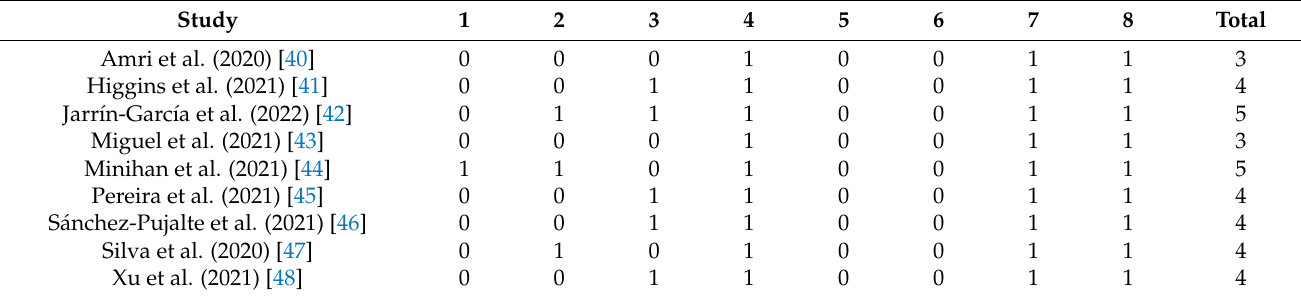
quate response rate (>70%) and description of losses; (7) Confidence intervals and subgroup analysis; (8) Study subjects described. Nine studies reported prevalence of burnout data, which ranged from 22.1% to 85% (Table 1). Our estimated overall prevalence of burnout was 52% (95% CI: 33–71%), with significant heterogeneity between studies ( Q test: p -value < 0.001; I 2 = 99%) (Figure